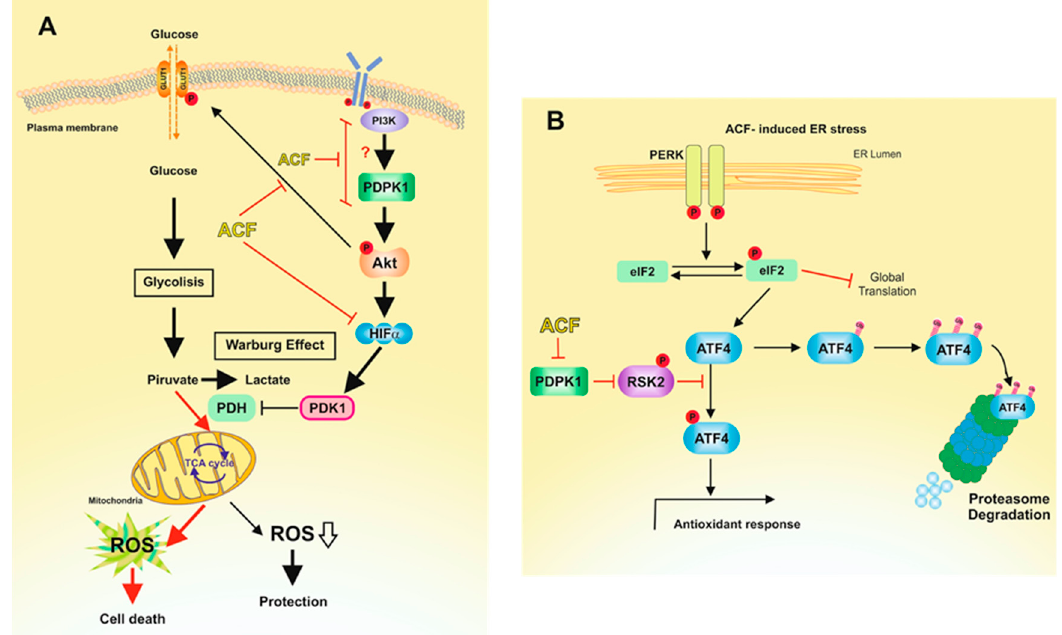
Figure 6. Proposed mechanisms for the action of ACF on melanoma cells under normoxic conditions. ( A ) This picture reproduces the adaptation of melanoma cells to physiological concentrations of glucose. Restriction of glucose availability to physiological concentrations induces the production of ROS [16], which activate HIF-1 α [46]. Activated HIF-1 α induces glycolysis upregulation in cancer cells, a phenomenon known as the Warburg effect [47]. Thus, by increasing the conversion of pyruvate to lactate, the Warburg effect reduces ROS production by the mitochondrial OXPHOS. Activated AKT pathway contributed to glucose transport through GLUT1 plasmatic membrane translocation and activation of HIF-1 α . ACF, by inhibiting HIF-1 α , impedes PDK1 transcription, resulting in enhanced ROS production. In this metabolic scenario, ACF blocks the PI3K/PDPK1 pathway, resulting in impaired phosphorylation of AKT. Consistently with our results (Figure 2A), inhibition of AKT phosphorylation by ACF would also result in reduced expression of HIF-1 α [31] under normoxic conditions. Red arrows indicate favored pathways in the presence of ACF. ( B ) Increased ROS levels induces ER stress, leading to the UPR [48]. Although ACF induces the phosphorylation of eIF2 α , this is not traduced in elevated expression of ATF4. Since protein stability of ATF4 is dependent of an operative PDPK1/RSK2 pathway [29], ACF induces the destabilization of ATF4 and, therefore, the inactivation of ATF4-adaptative pathways.